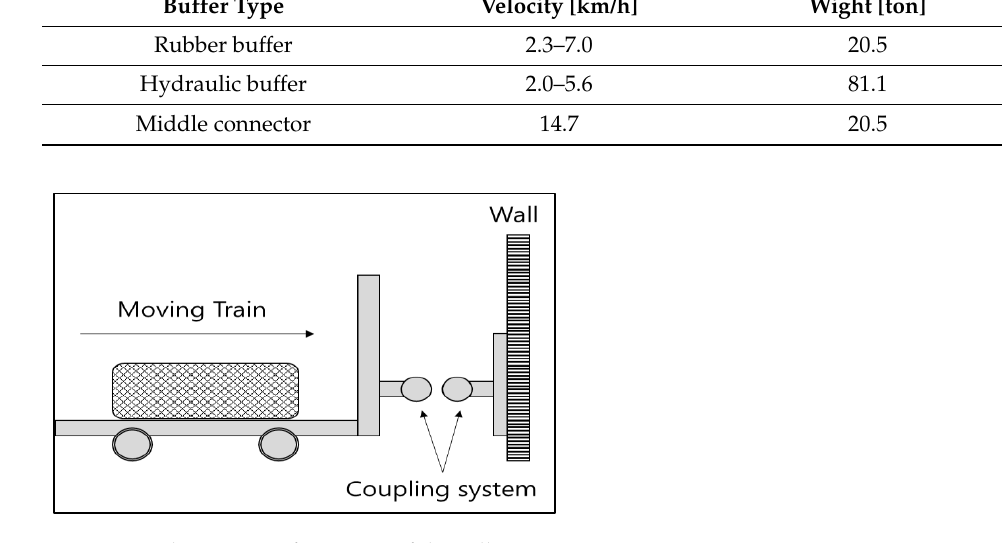
Table 1. Collision test conditions.